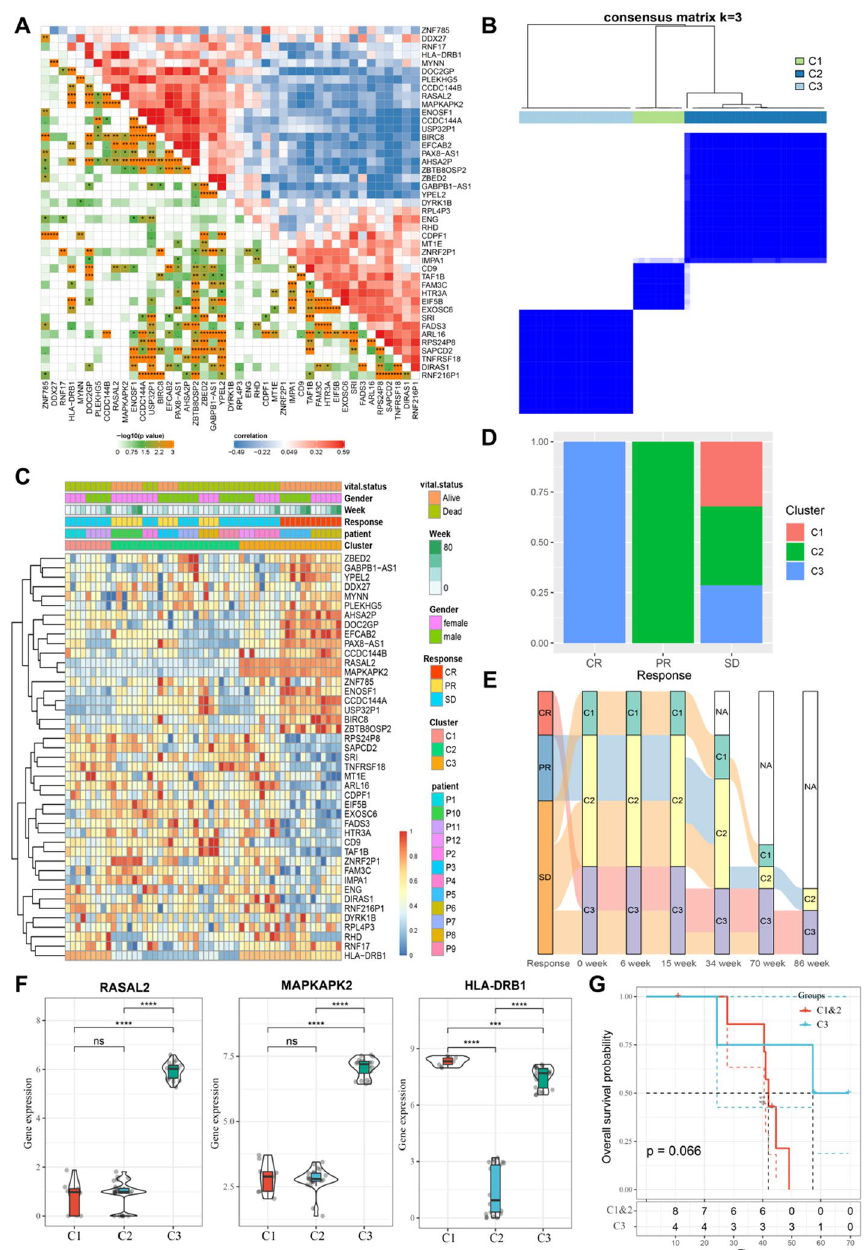
Fig. 3 Response-related clusters in PBMC samples. a The interaction of 43 RRGs in PBMC samples of LGG. Correlations are calculated by spearman correlation analysis. Positive correlation is indicated in red and negative correlation in blue. b Consensus heatmap (k 3) based on 43 RGGs expression profile, displaying = the clustering stability using 1000 iterations of unsupervised clustering. c The heatmap of 43 RRGs expression in the PBMC samples. The response-related cluster, patient ID, treatment response, samples drawn at weeks, vital status and gender were used as patient annotations. Red represented high expression of RRGs and blue represented low expression. d The proportion of response-related clusters in SD, PR and CR samples. Cluster 1, red; Cluster 2, green; Cluster 3, bule. e Alluvial diagram showing response-related clusters of samples from SD, PR and CR patients at different time points. f Differential expression of RASAL2, MAPKAPK2 and HLA-DRB1 in different clusters. The differences between every two groups were compared through the Kruskal–Wallis test. g Kaplan–Meier curve for OS showing the difference in survival between cluster 3 and cluster 1/2 (log-rank test, p 0.066). P < 0.1, * P < 0.05, ** P < 0.01, *** P < 0.001, **** P < =